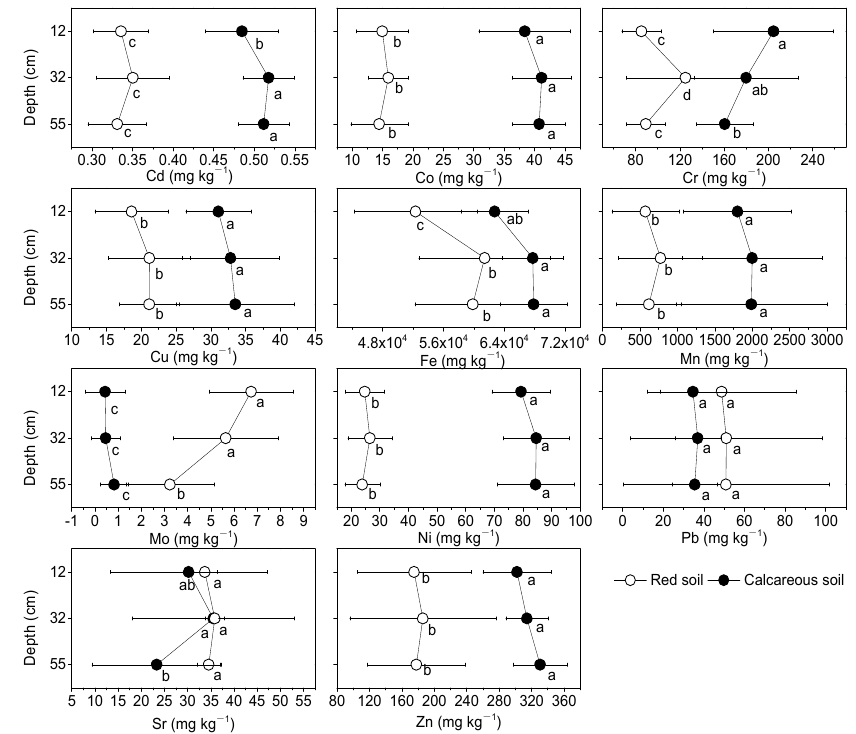
Figure 1. The distribution of the total content (C T ) of heavy metals in the soil profile, including cadmium (Cd), cobalt (Co),chromium (Cr),copper (Cu), iron (Fe), manganese (Mn), molybdenum (Mo), nickel (Ni), plumbum (Pb), strontium (Sr), and zinc (Zn). Identical lowercase letters indicate no significant differences among all soil layers in calcareous and red soils at p = 0.05, N = 12.